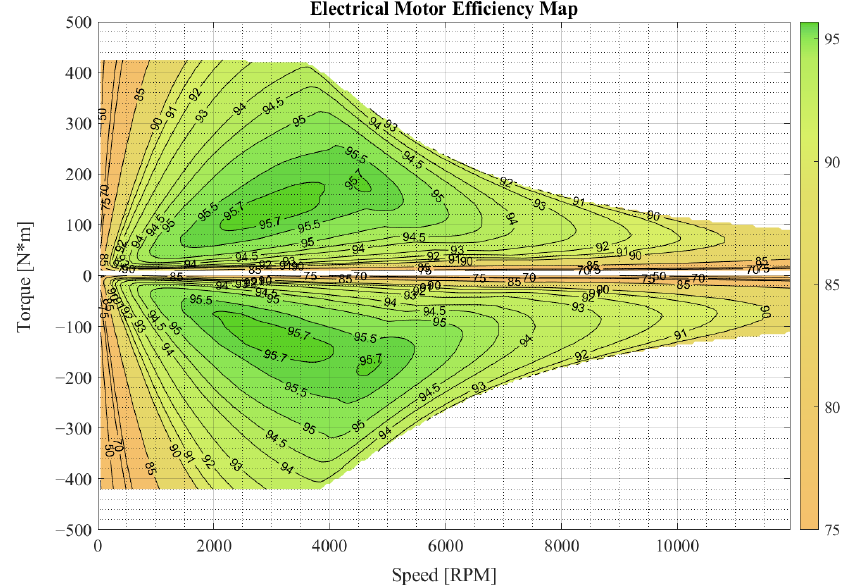
Figure 8. The mechanical characteristic and efficiency curves of the designed electric